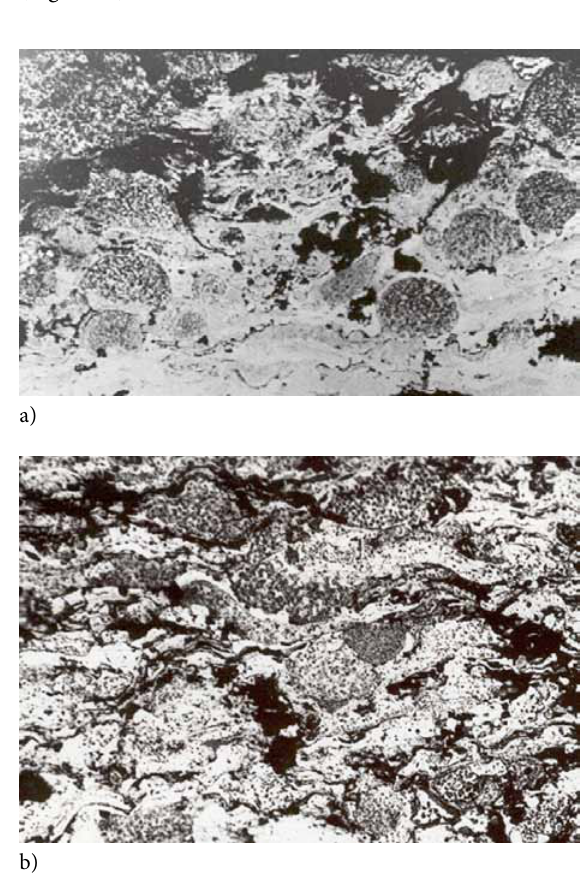
Fig. 2. Initial microstructure of the plasma coating (a); and microstructure of the plasma coating after the laser treatment in the thermal cycling mode, ×500